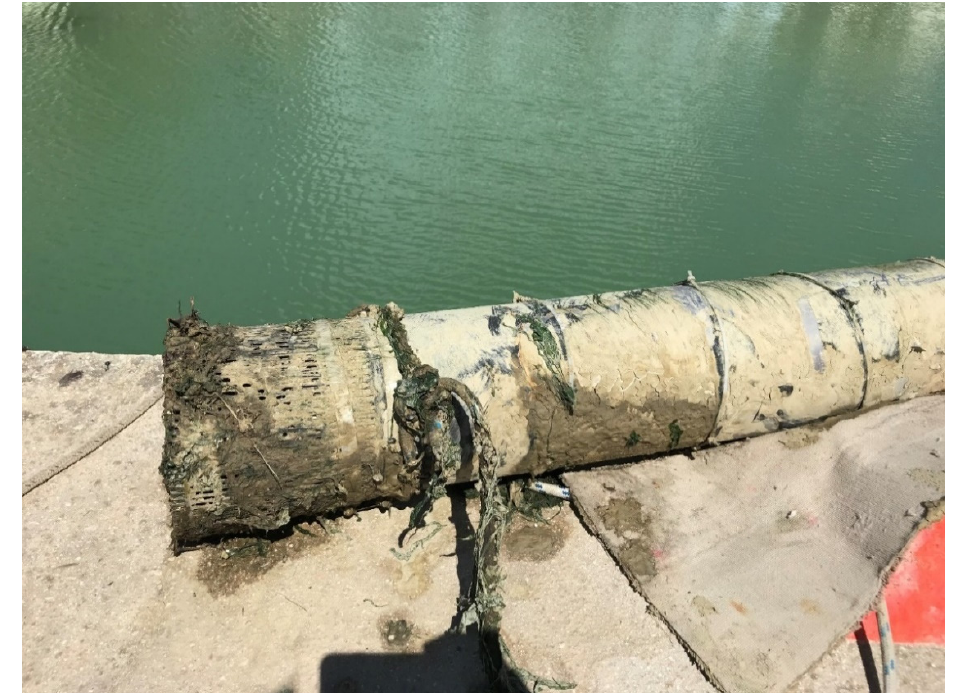
Figure 9. Fouling of the external filter of the pump; picture taken on 2 of May 2019, before cleaning. J. Mar. Sci. Eng. 2020 , 8 , x FOR PEER REVIEW 16 of 19